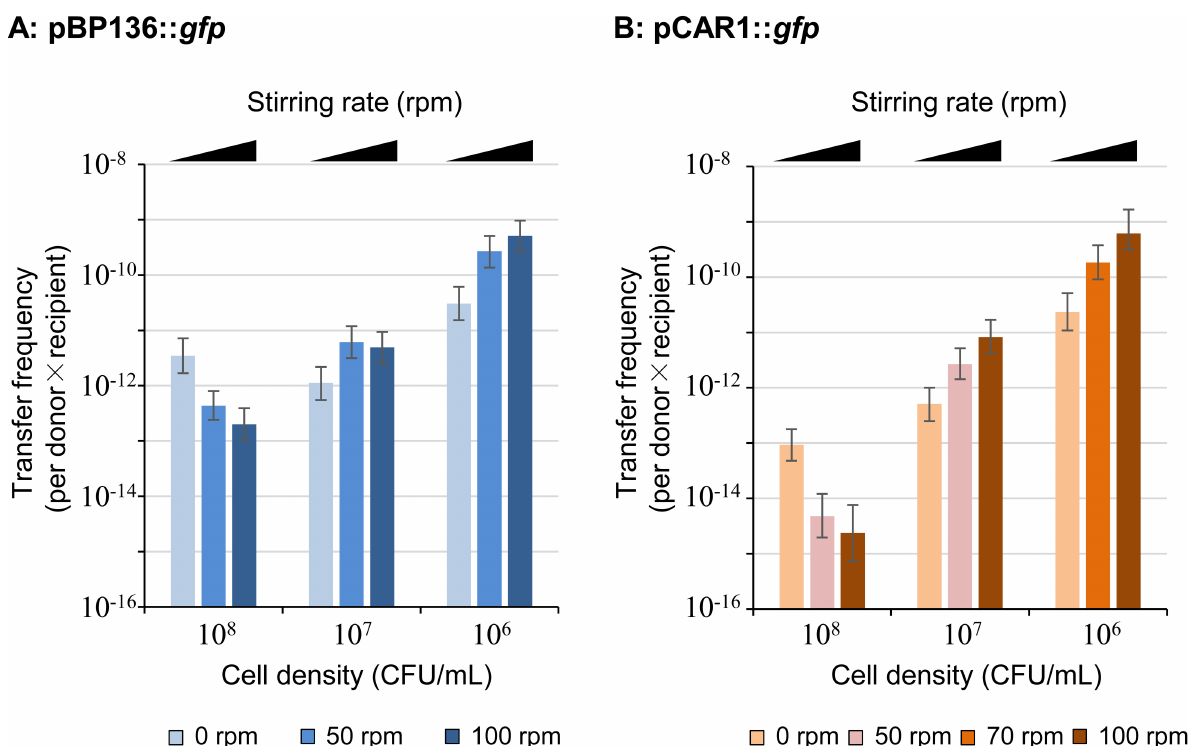
Fig 2. Comparisonsof the transfer frequency of pBP136:: gfp (A) or pCAR1:: gfp (B) with different cell densities,10 8 , 10 7 , and 10 6 CFU/mL in different stirring conditions (0, 50 or 70, and 100 rpm). The raw data of this figure are in S2 Table.